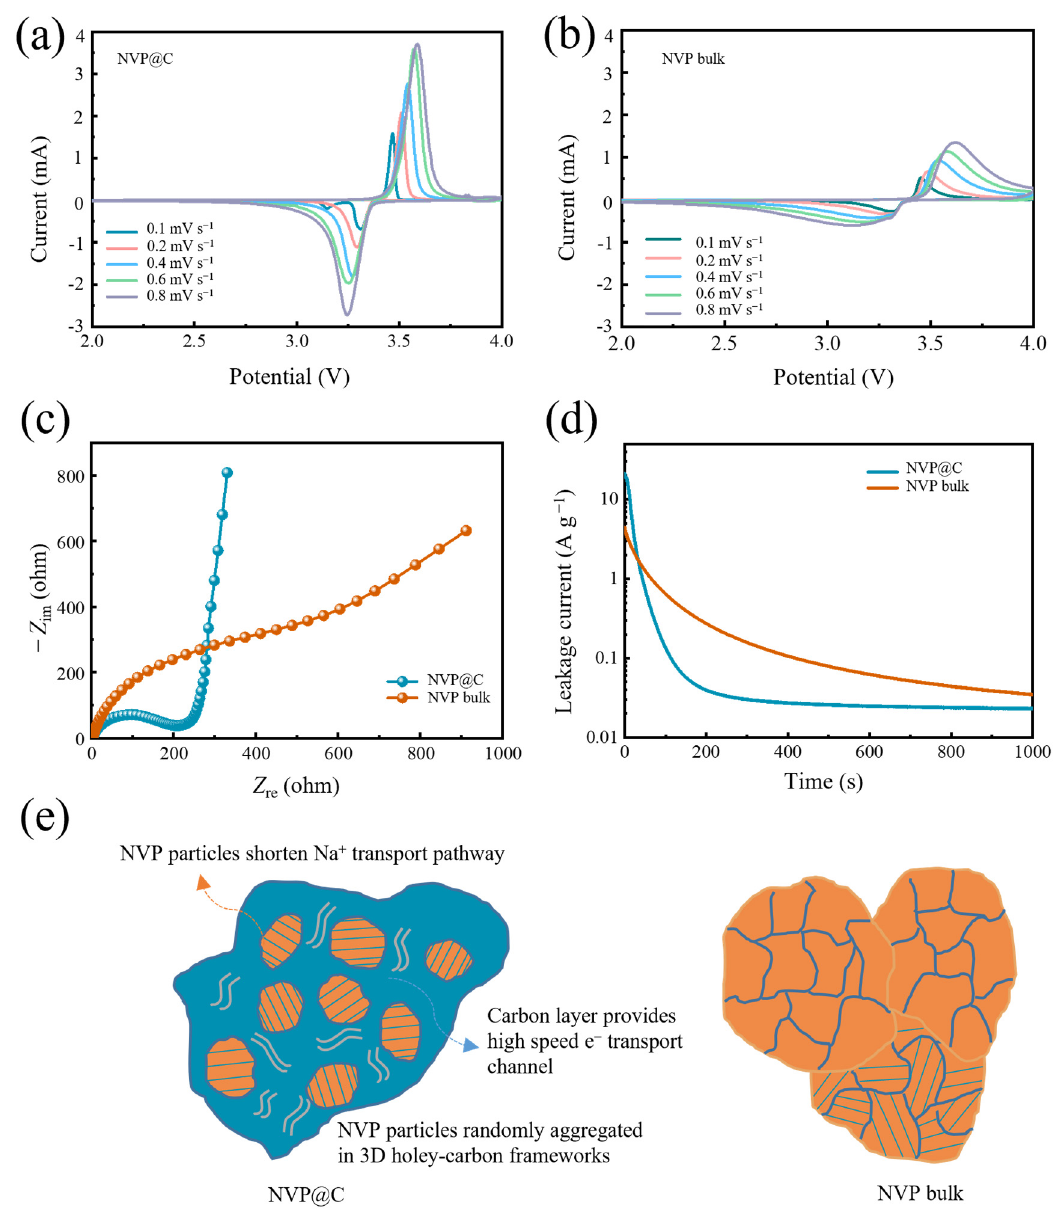
Figure 4. ( a ) NVP@C and ( b ) NVP bulk at rates from 0.1 to 0.8 mV s –1 ; ( c ) Nyquist plots of NVP@C and NVP bulk for the frequencies ranging from 0.01 to 100K Hz during discharge state; ( d ) leakage current of NVP@C and NVP bulk in floating tests; ( e ) schematic transport process of Na + in NVP@C and NVP bulk.